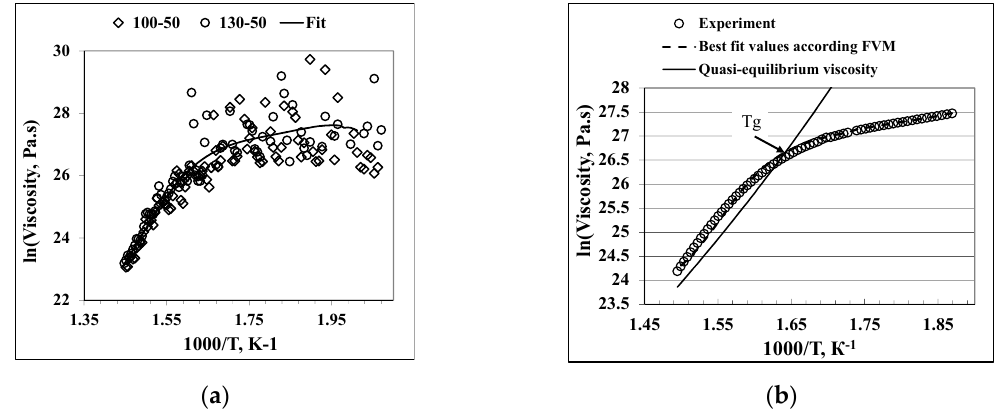
Figure 3. Viscosity temperature dependence of the Pd 40 Ni 40 Si 20 glassy alloy at a heating rate of 20 K/min, calculated from load differences ( a ) and the viscosity temperature dependence of the Pd 40 Ni 40 Si 20 glass: points—experimental values; broken line—best fit values, according to FVM; and the steep solid line—quasi-equilibrium viscosity ( b ). The cross point of the non-equilibrium and quasi- equilibrium viscosity determines the glass transition temperature T g .